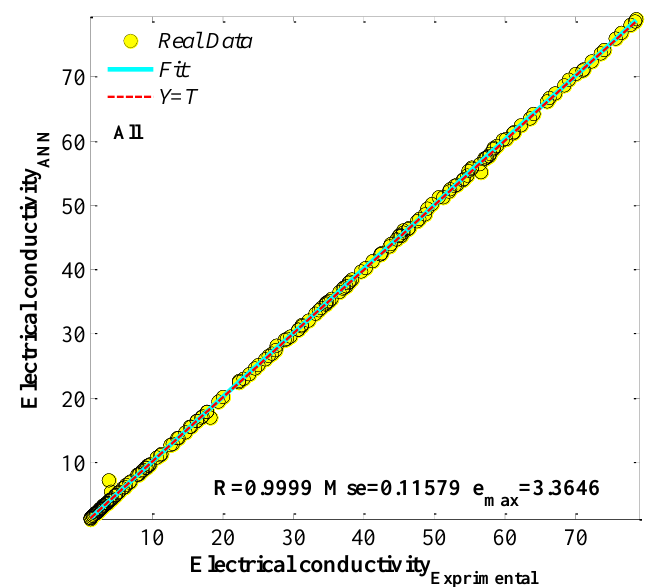
Figure 8. Comparison of predicted values of electrical conductivity of nanofluids by neural networks and experimental results for testing data .